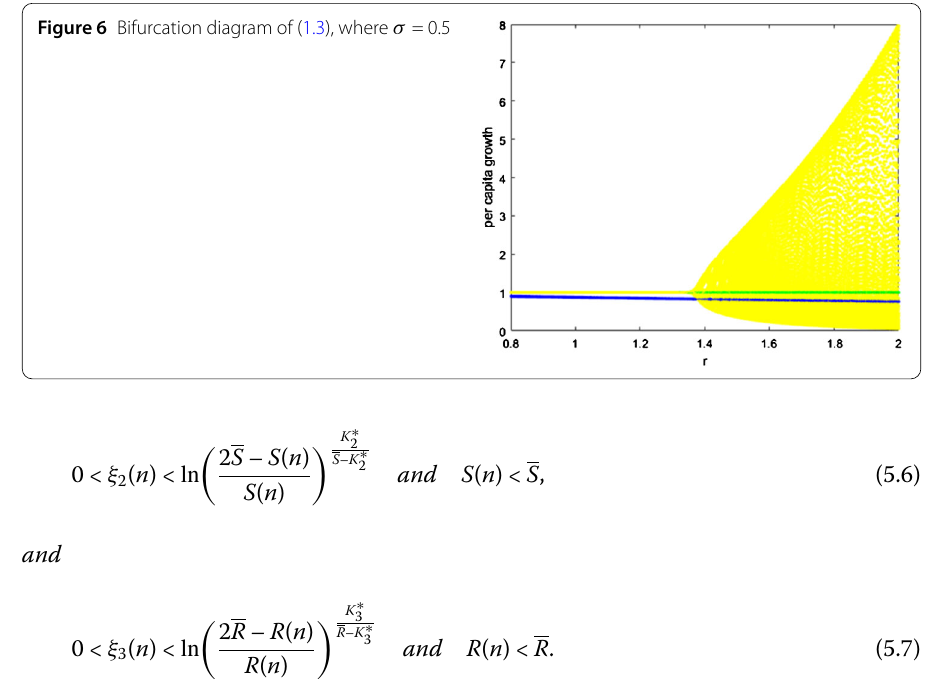
Figure 6 Bifurcation diagram of (1.3), where σ =